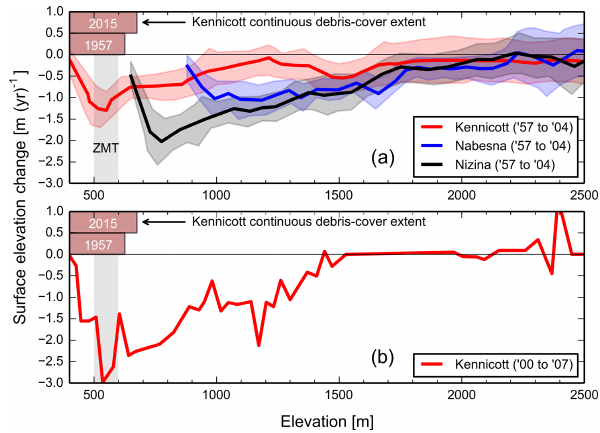
Figure 1. Map of Kennicott Glacier and the study area. (a) Map of Alaska showing the location of the Wrangell Mountains. (b) Ken- nicott Glacier with the location of the Gates Glacier meteorological station (1240m a.s.l.). May Creek meteorological station is located 15km to the southwest of the terminus at 490ma.s.l. Contour in- tervals are 250m based on the ASTER GDEM V2 (2009). (c) Map of the general study area with d H (d t ) − 1 from 1957 to 2004 (Das et al., 2014). ZMT refers to the zone of maximum thinning, the extent of which is shown with the double-headed arrow. This map of the study area includes the bare-ice parts of Root and Kennicott glaciers, where some ablation measurements were made. Elevation contours are from 2013. The units for the legend are above the la- beled colors.